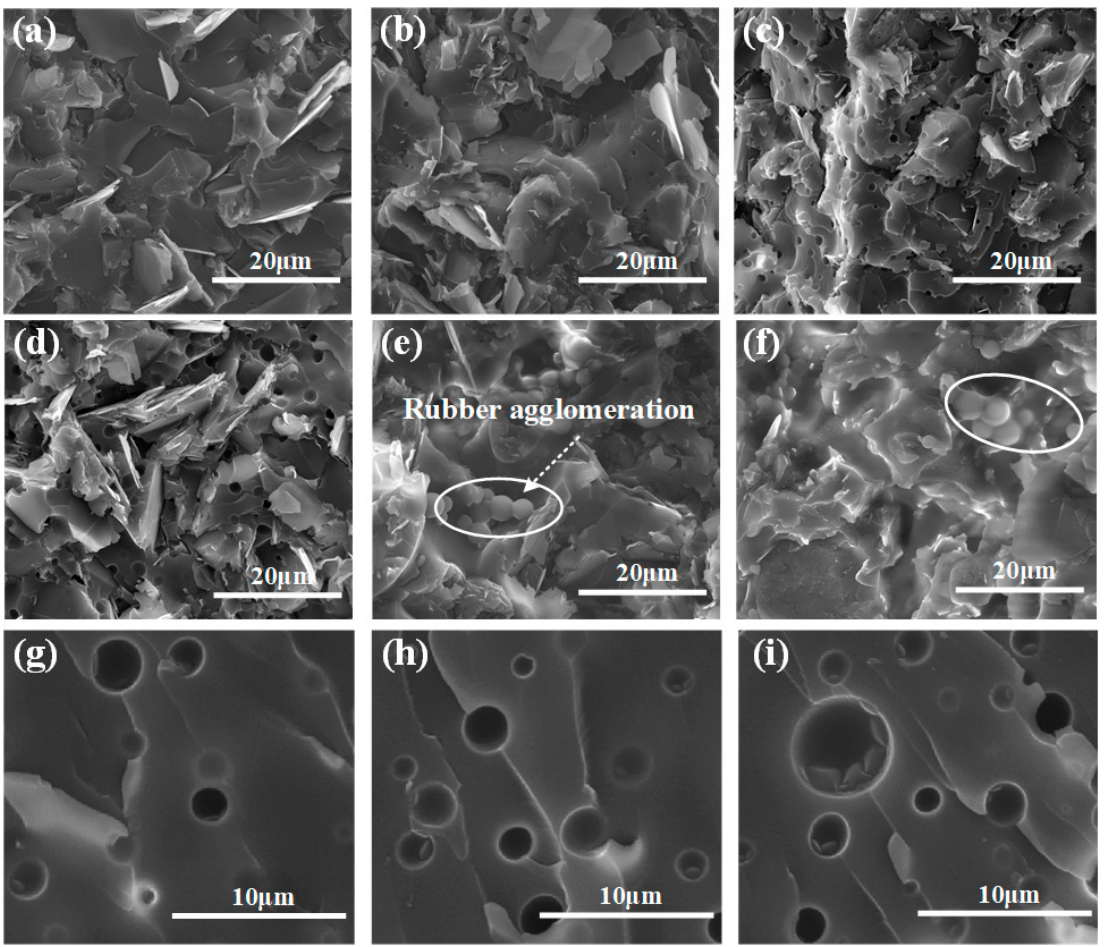
Figure 1. SEM images of epoxy composites. ( a ) 0 wt.% CTBN; ( b , g ) 5 wt.% CTBN; ( c , h ) 10 wt.% CTBN; ( d , i ) 15 wt.% CTBN; ( e ) 20 wt.% CTBN; ( f ) 30 wt.% CTBN.